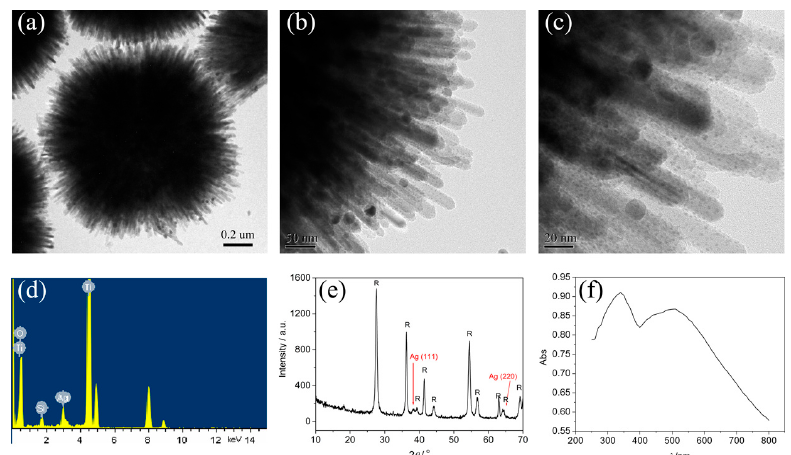
Figure 13. TEM images ( a – c ), EDS ( d ), XRD ( e ), and UV-Vis absorption spectrum ( f ) of Ag-decorated 3D urchin-like TiO 2 nanostructures [31].